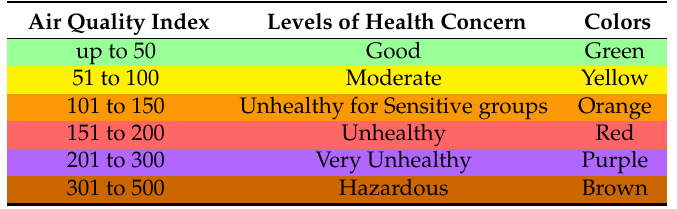
Table 1. Health effects of the Air Quality Index